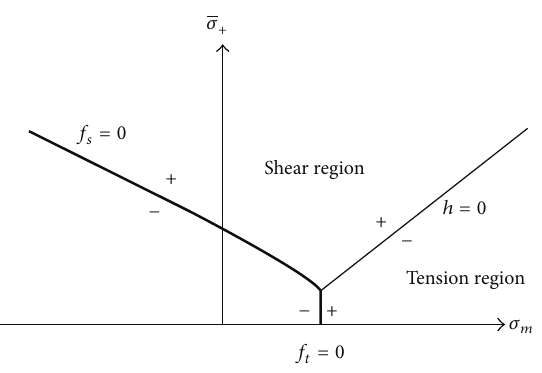
Figure 30: The shear and tension failure region using the flow rule of synergic Zienkiewicz-Pande constitutive